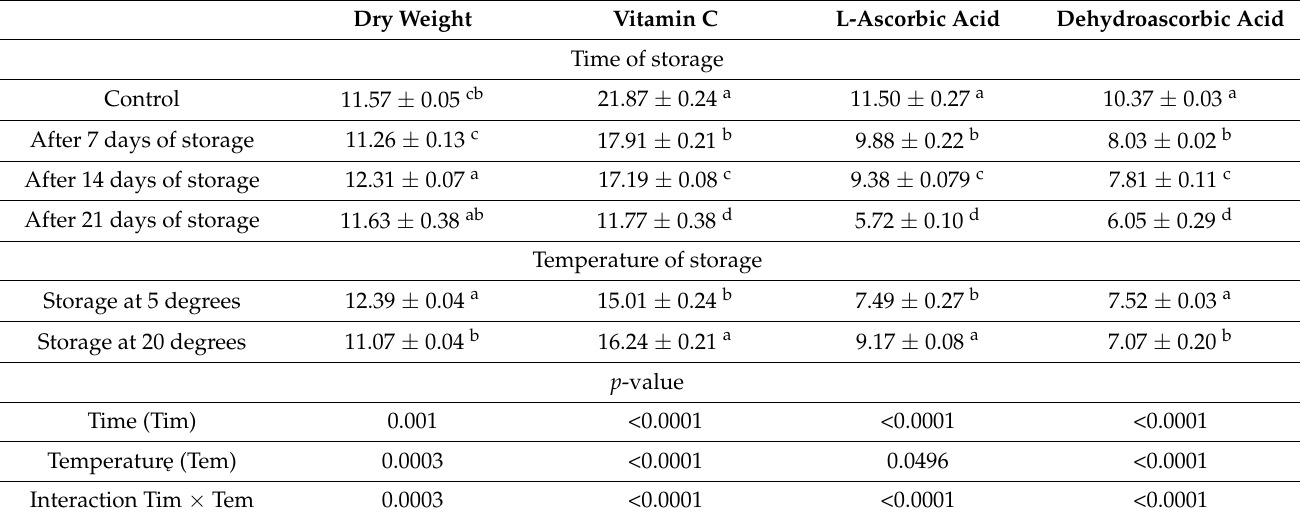
Table 1. The content of dry weight (in g/100 g FW) and vitamin C in apple (in mg/100 g